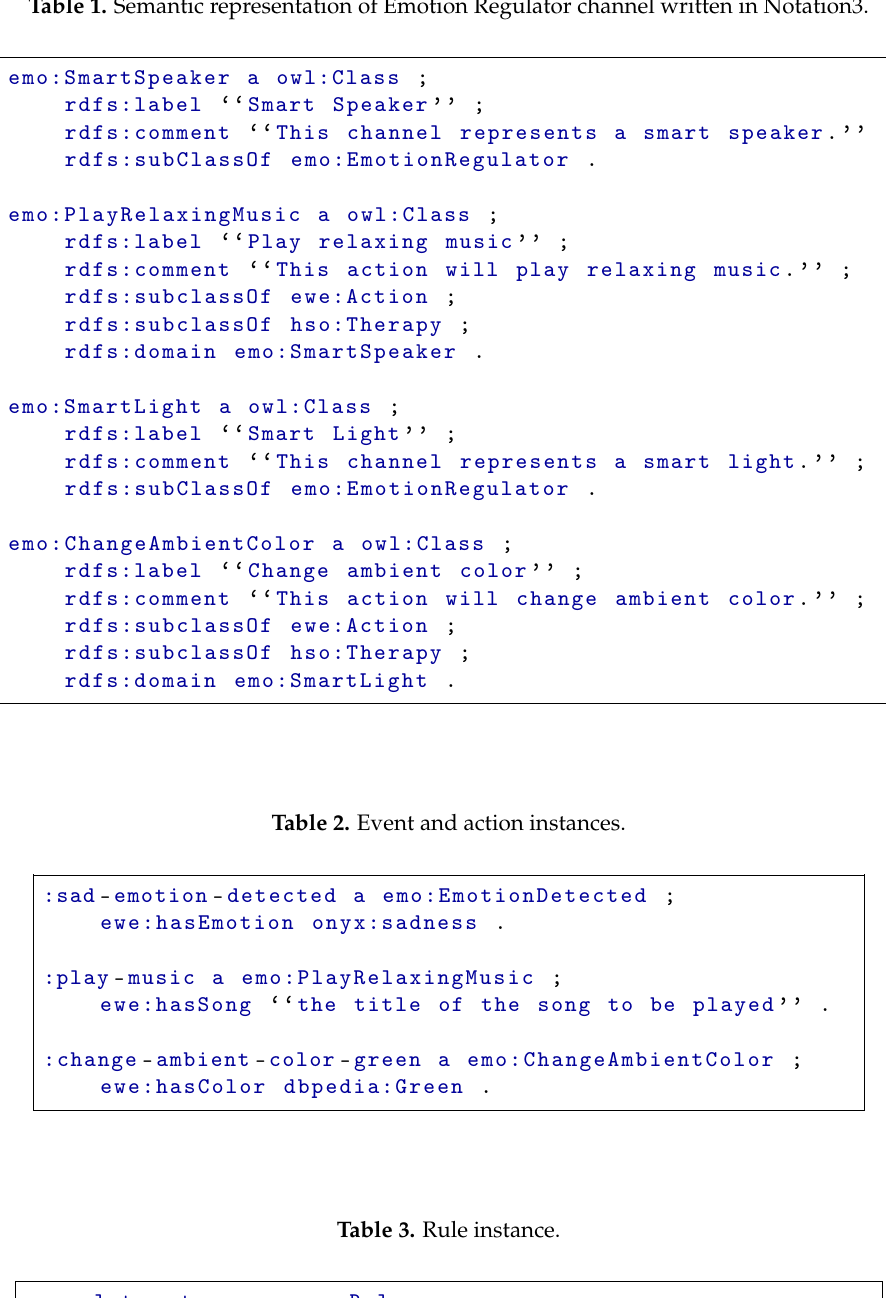
Table 1. Semantic representation of Emotion Regulator channel written in Notation3.